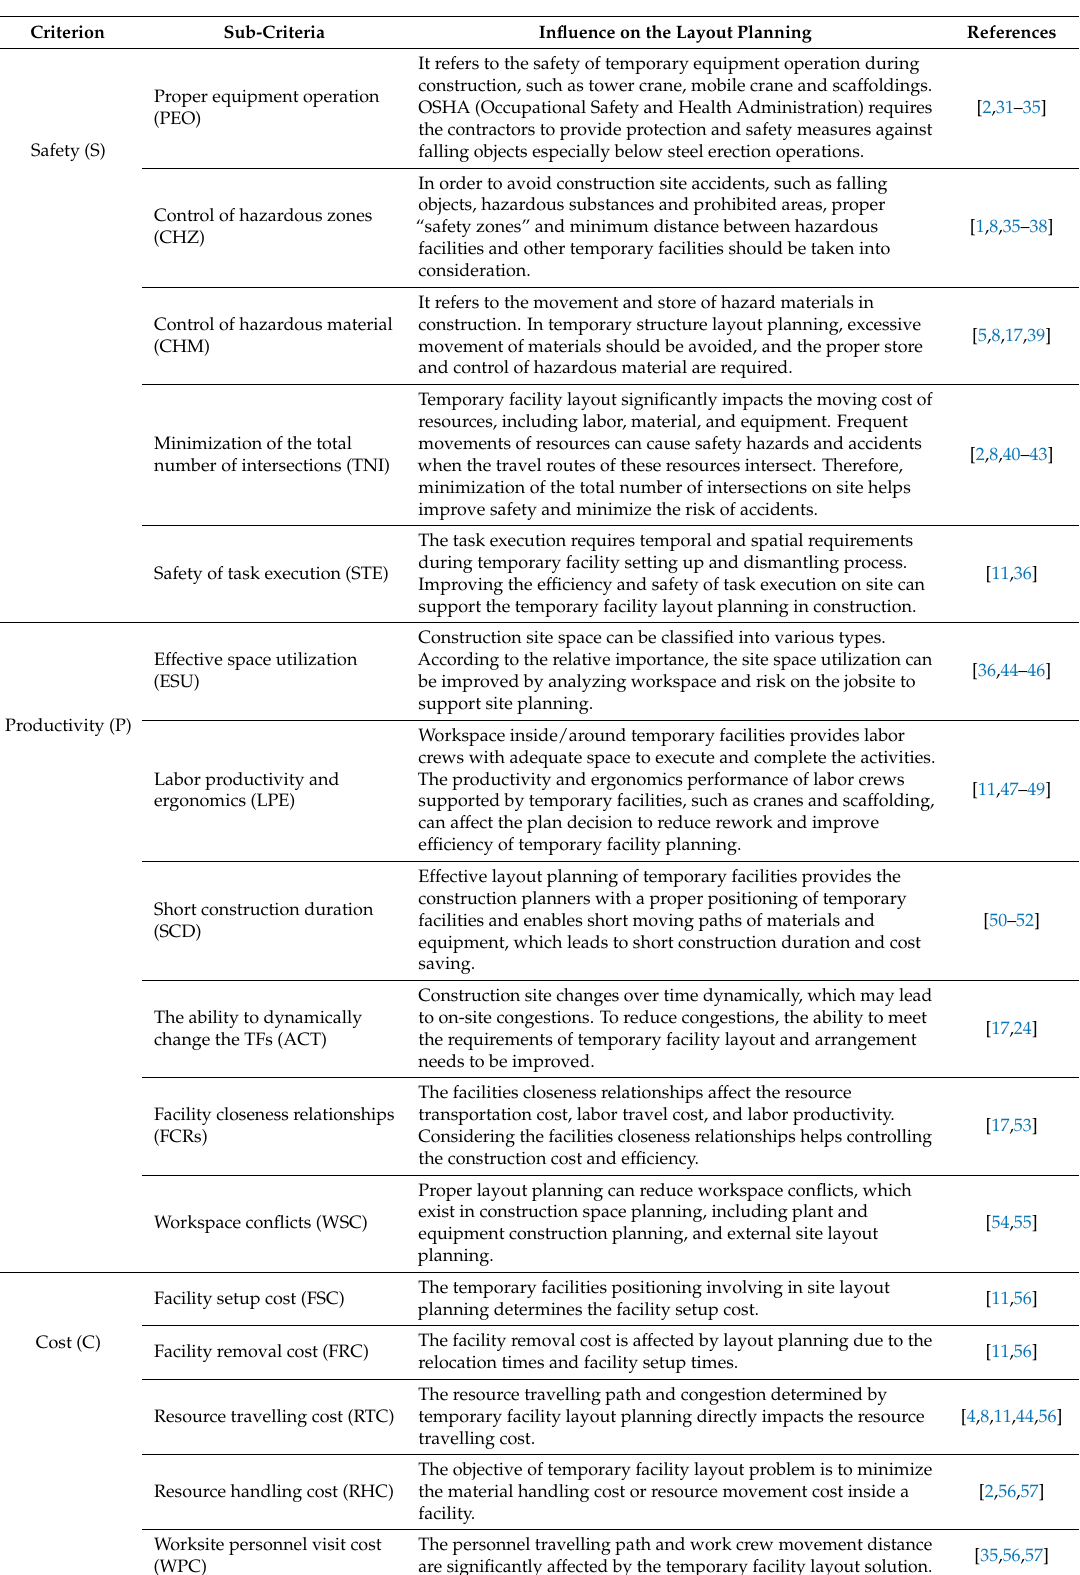
Table 1. Sub-criteria of safety criterion and their influence on the safety